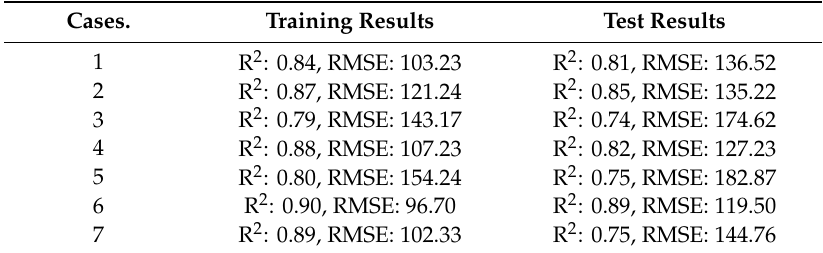
development through